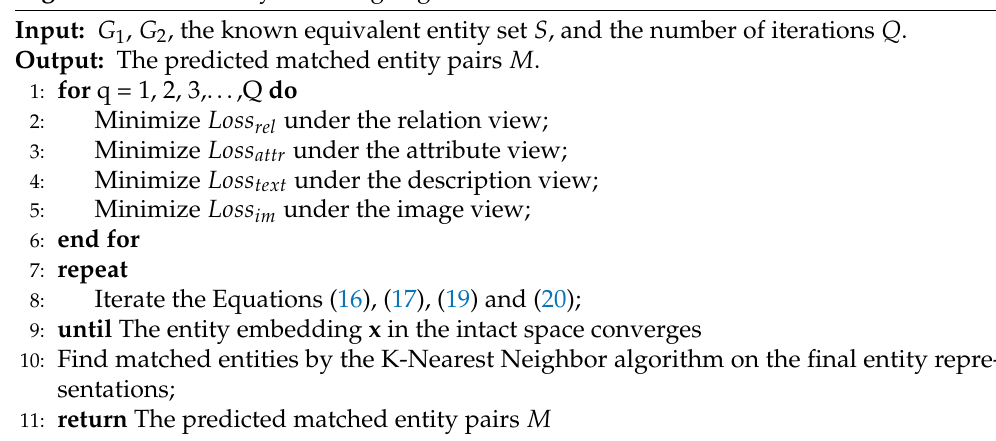
Algorithm 1 The Entity Matching Algorithm in CLEM.